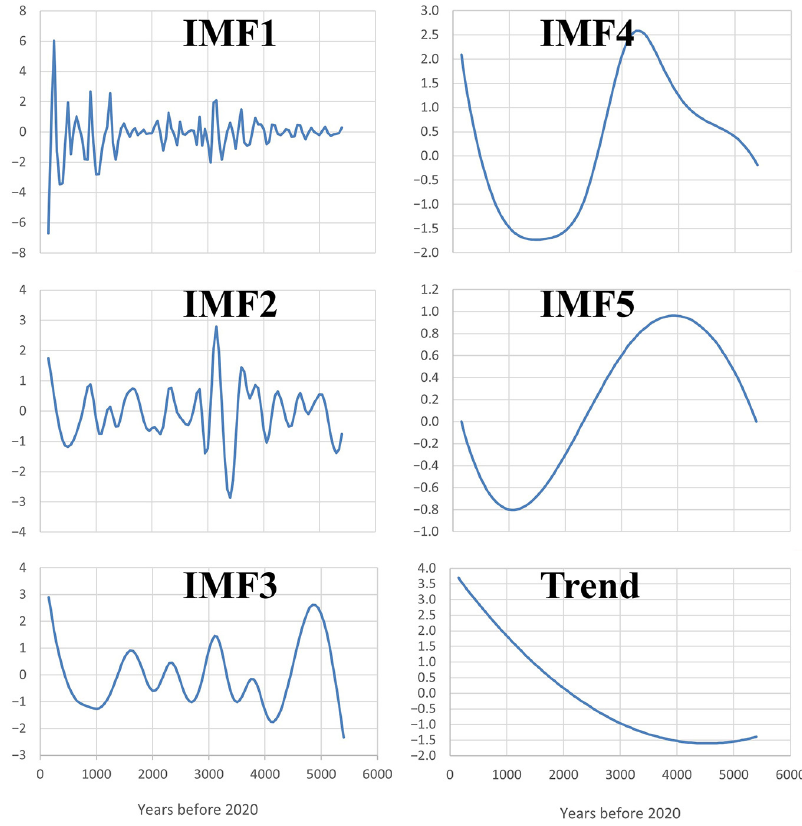
Figure 12. EEMD of the deseasonalized and detrended reconstructed water table depth timeseries in five IMFs and a trend.